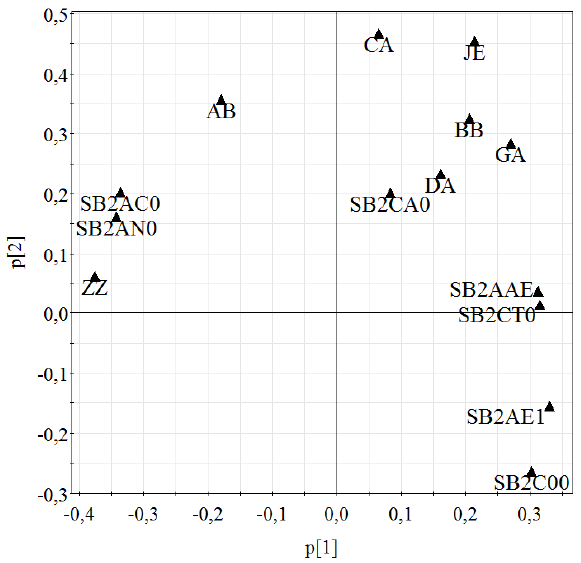
Figure 7. Loading plot of Figure